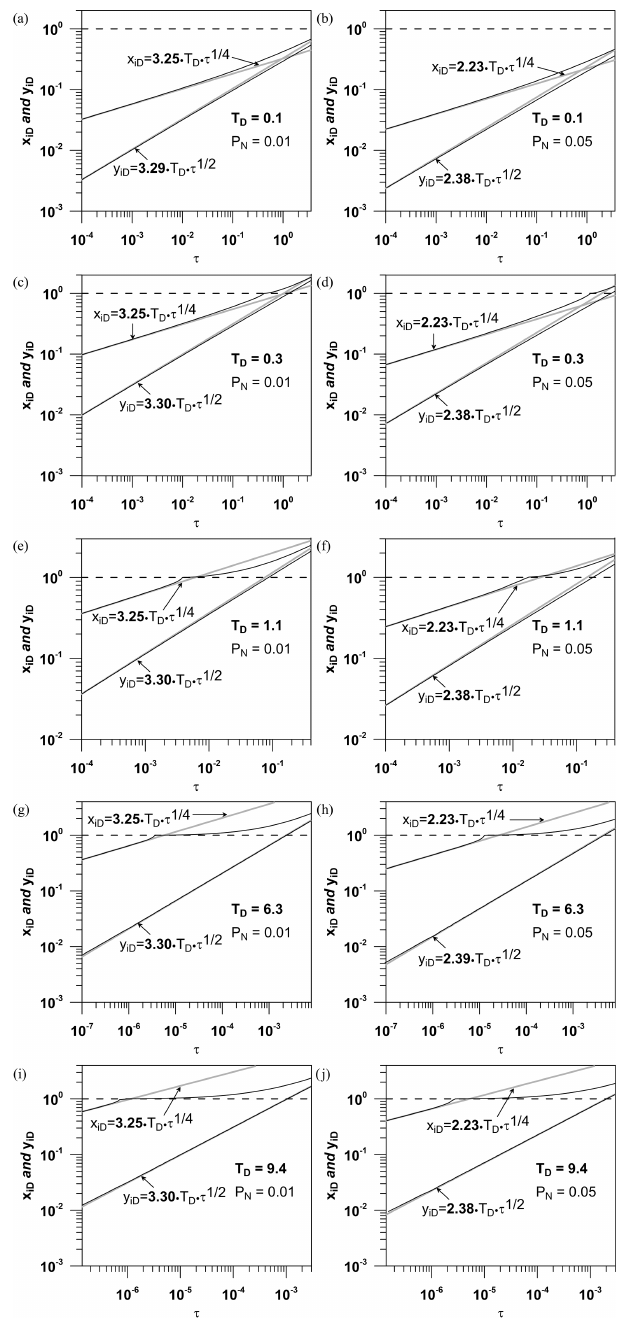
Figure 4. Model results display x iD and y iD vs. τ on a log–log scale. Propagation of isobars P N = 0 . 01 (a, c, e, g, i) and P N = 0 . 05 (b, d, f, h, j) along the fracture and the formation considering the fol- lowing dimensionless fracture conductivities: T D = 0 . 1 (a, b) , 0 . 3 (c, d) , 1 . 1 (e, f) , 6 . 3 (g, h) , and 9 . 4 (i, j) . The dashed lines represent the arrival at the fracture tip of the specific isobars indicated in the